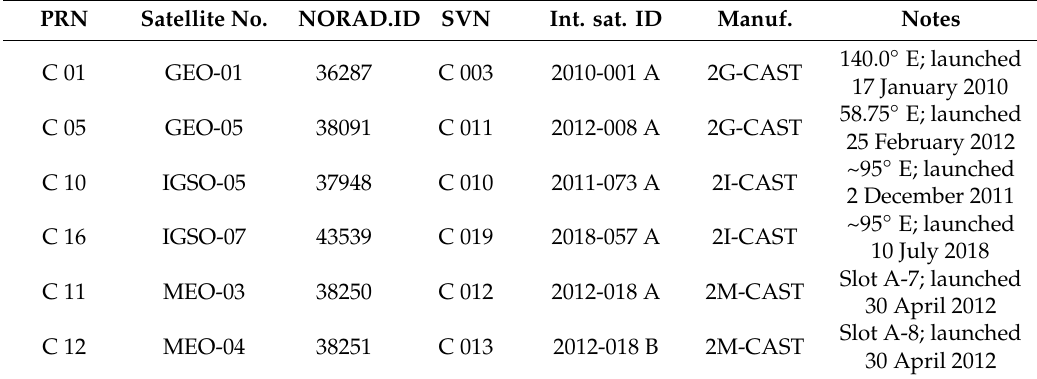
Table 1. Information on selected satellites (as of February